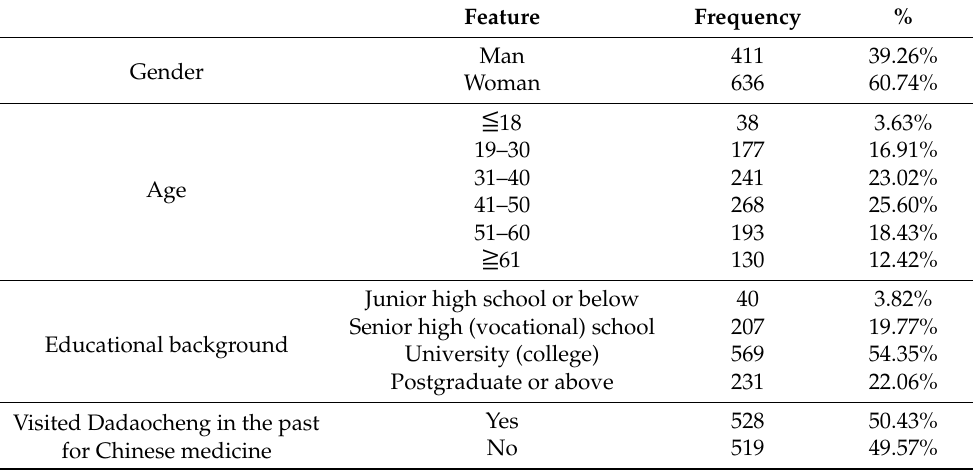
Table 1. Characteristics of the respondents (N = 1047).